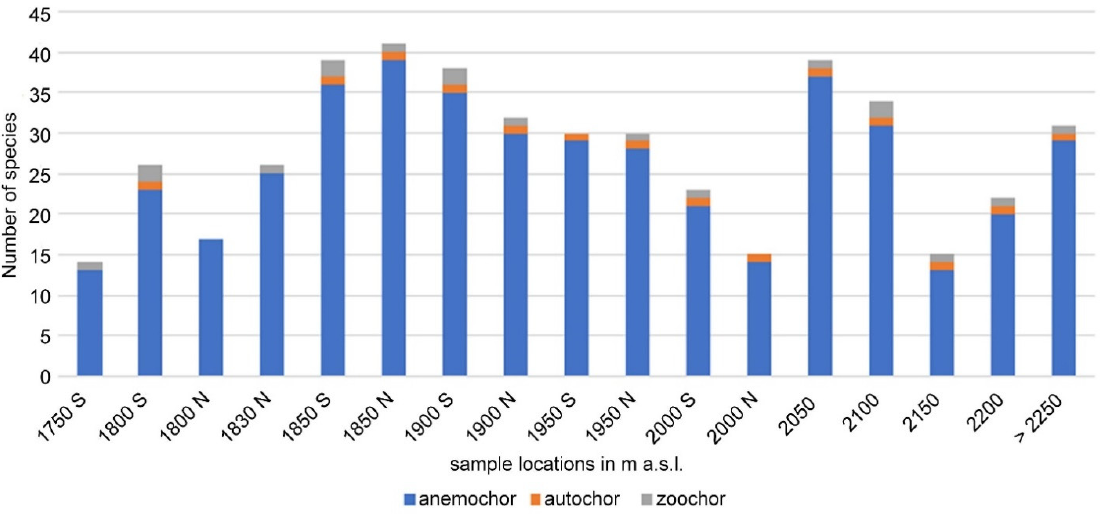
Figure 7. Predominant seed dispersal pathways (according to [100]) of species growing on Miage Glacier: anemochor = wind dispersed, autochor = without external forces by the plant itself, zoochor = dispersed by